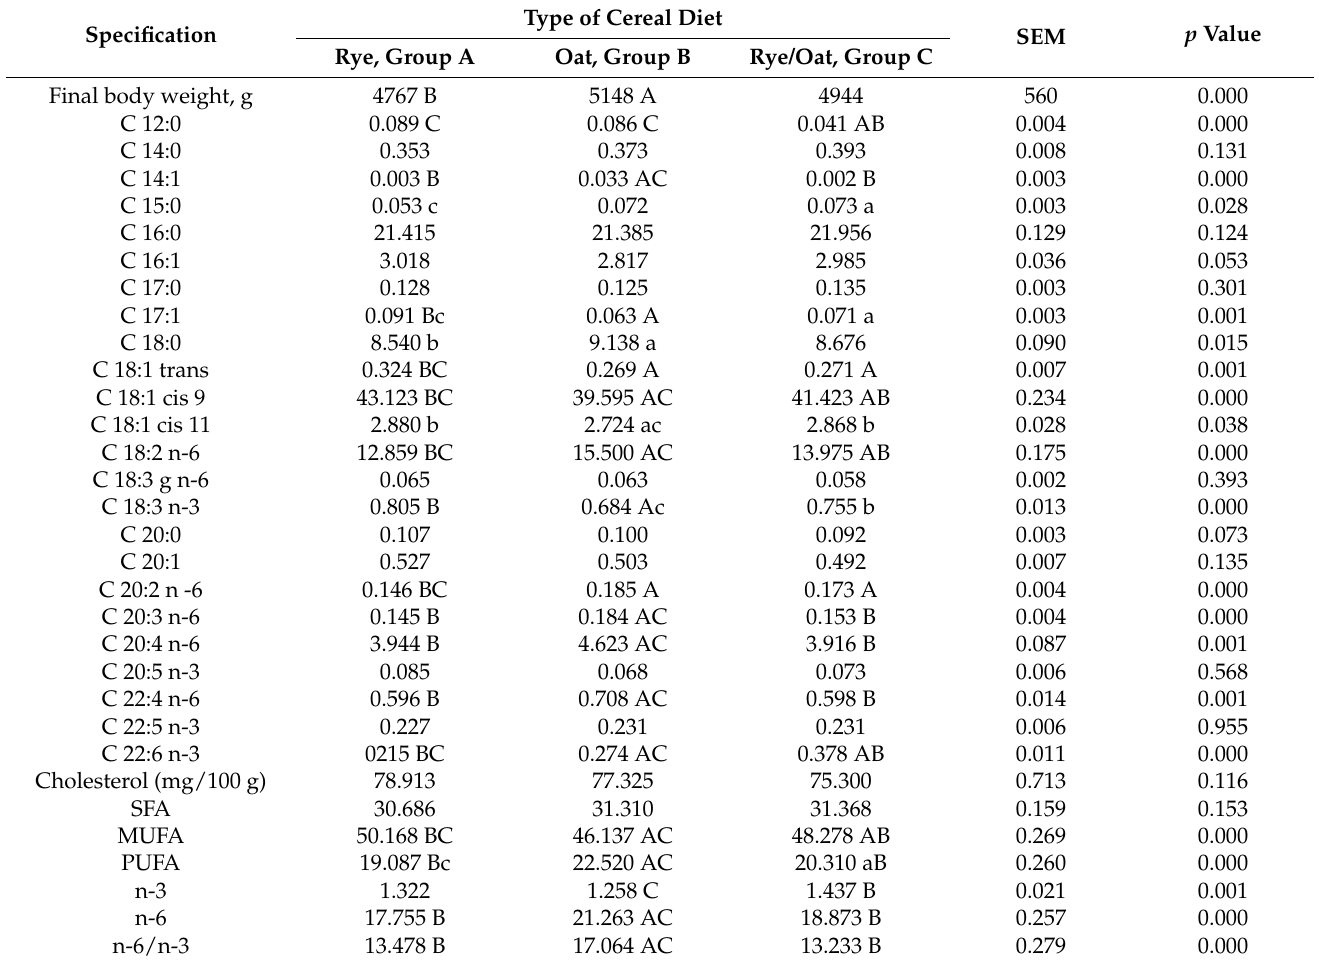
Table 5. Final body weight and fatty acids content in the breast muscles of geese fed with various cereals (%). Type of Cereal Diet Specification